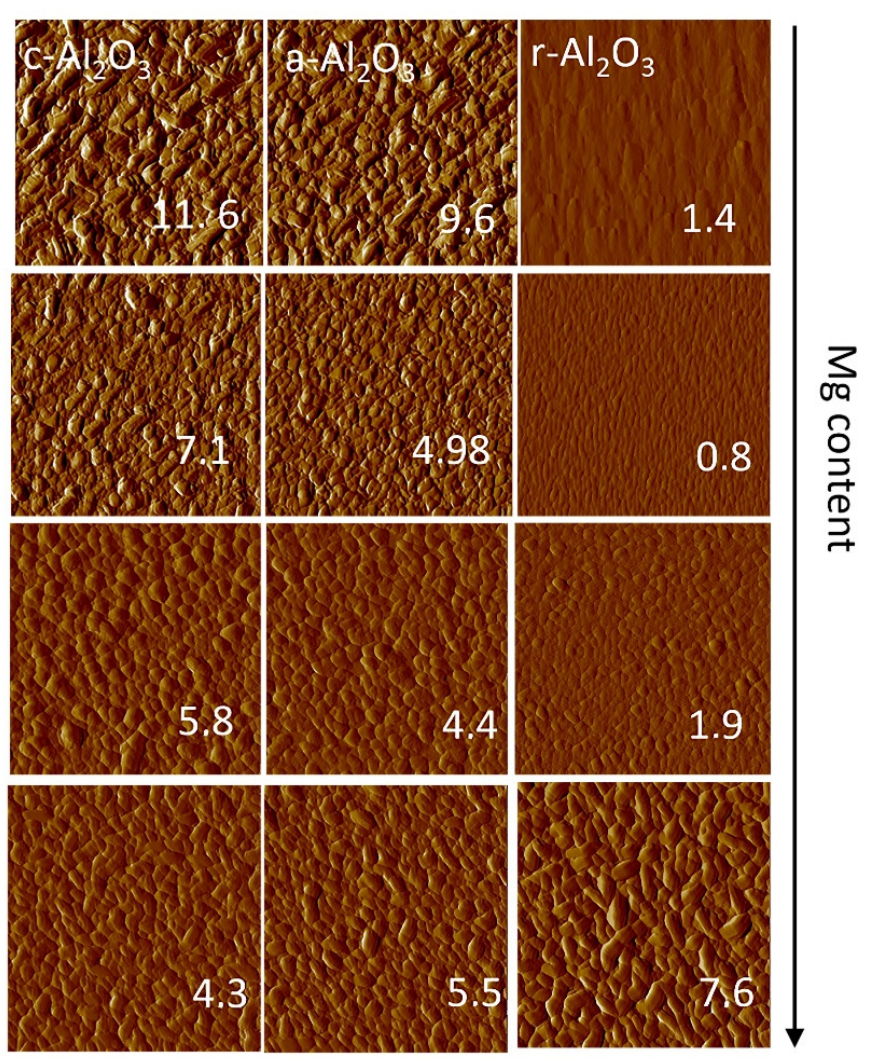
Figure 12. 2D AFM images of Zn 1 − x Mg x O thin films.